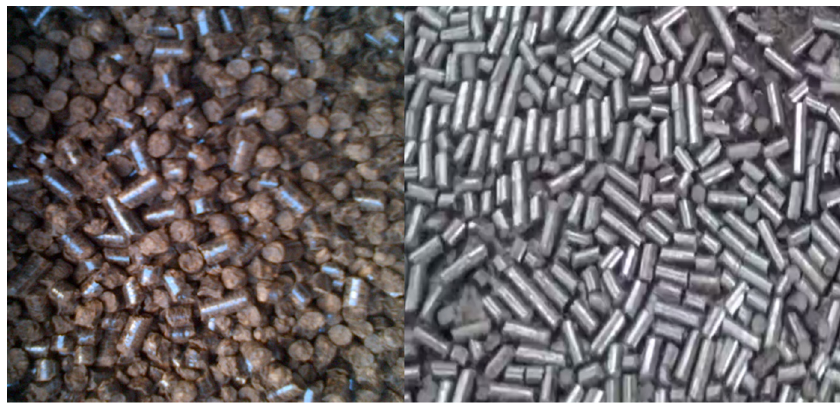
Figure 22. Left: pellets produced with torrefied biomass before the problems caused by poor extraction of the torrefaction gases have been solved. Visual analysis shows that they have a poorly consolidated appearance, despite the low degree of torrefaction indicated by the brownish color. Right: pellets of torrefied biomass produced after the implementation of the aforementioned corrective measures.